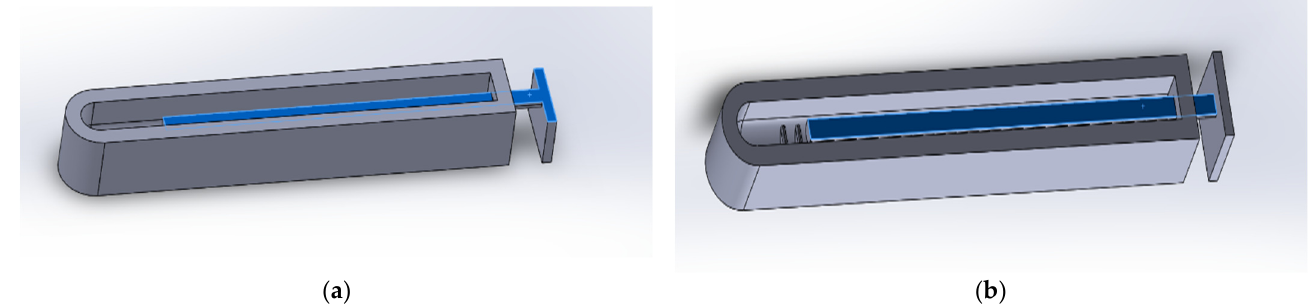
Figure 3. Mold rod design modified ( a ) compared to rod design ( b ) used in the literature [12].